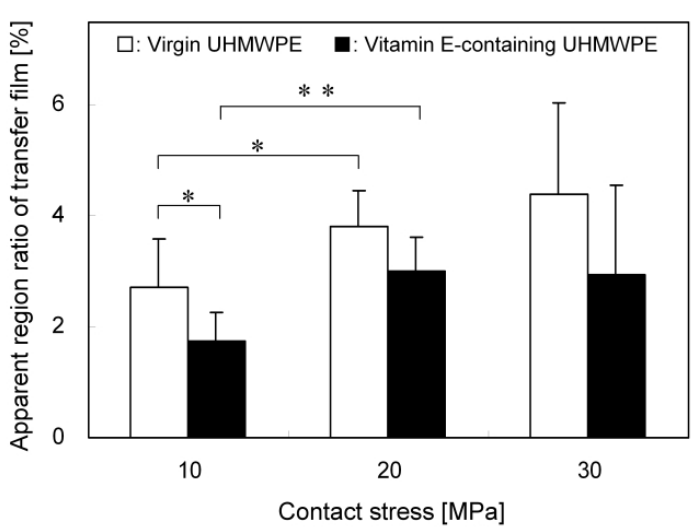
Fig. 6 Apparent region ratio of the UHMWPE transfer film formed on the Co-28Cr-6Mo alloy surface at different contact stress values. Data represent mean±SD.